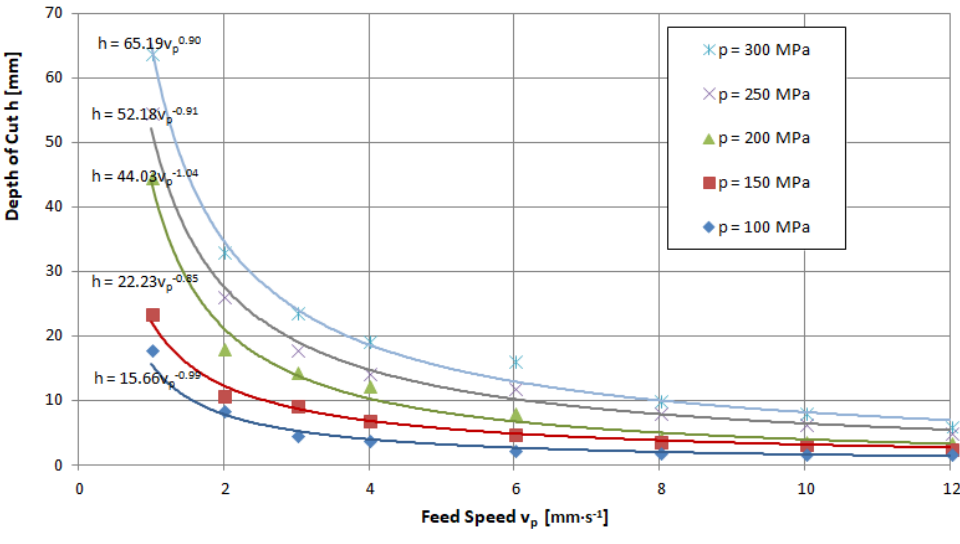
Figure 11. Influence of traverse speed and pressure on the depth of the cut of limestone: nozzle internal diameter d w =0.25 mm, flow of abrasive 𝑚(cid:4662) (cid:3028) = 6.7 g·s − 1 .